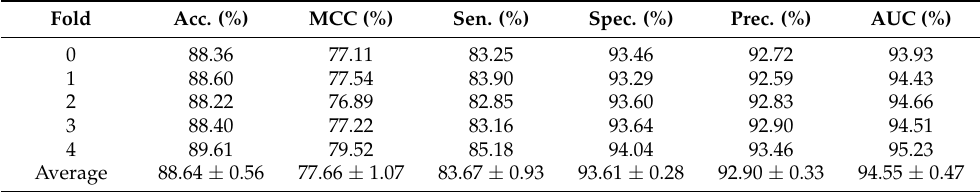
Table 1. Five-fold cross-validation results by random forest classifier.